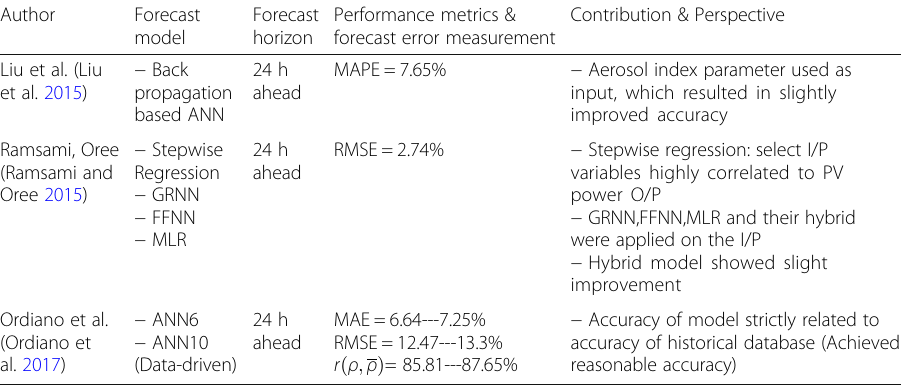
Table 2 State-of-the-art: Data-driven